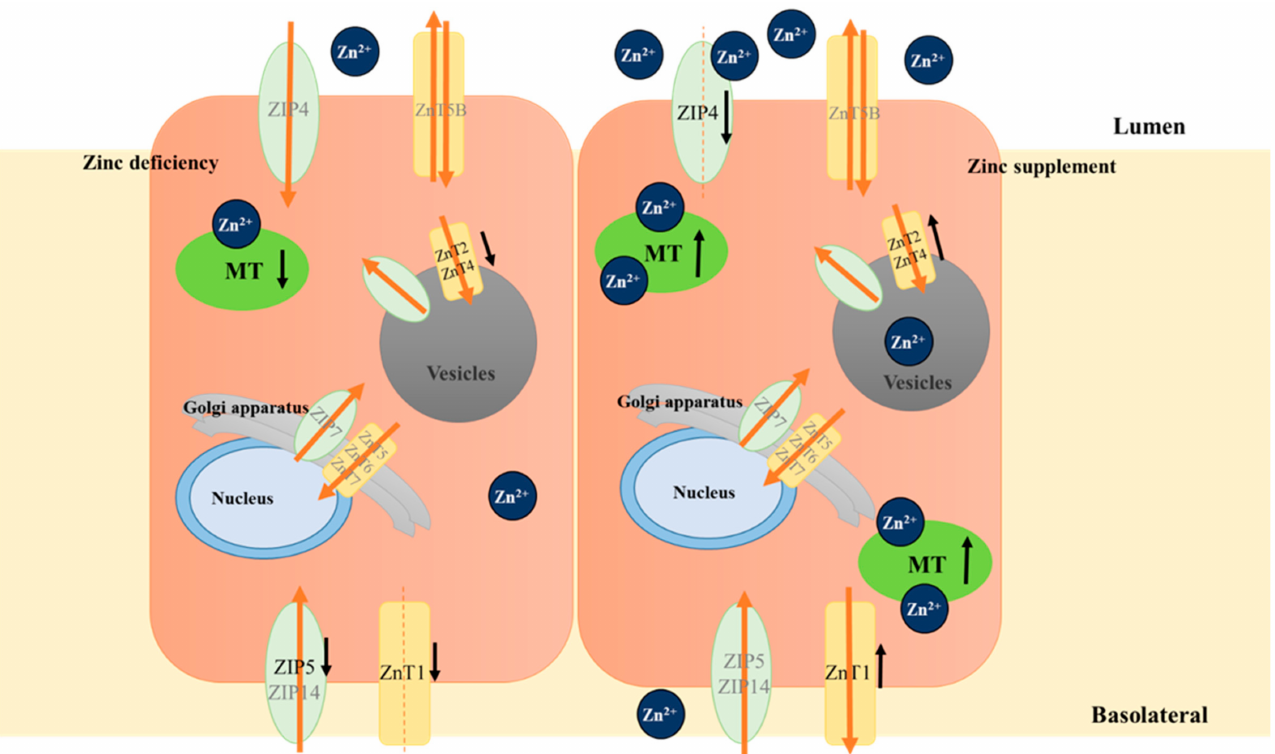
Figure 1. Zinc transporters (ZnT and ZIP) and zinc-binding proteins (MT) are involved in the regulation of intestinal zinc absorption, a potential regulatory mechanism of zinc absorption into enterocytes during zinc excess and zinc supplement. The red arrows indicate the direction of zinc flow, and the black arrows indicate changes in zinc transporters’ RNA and/or protein upon changes in the zinc